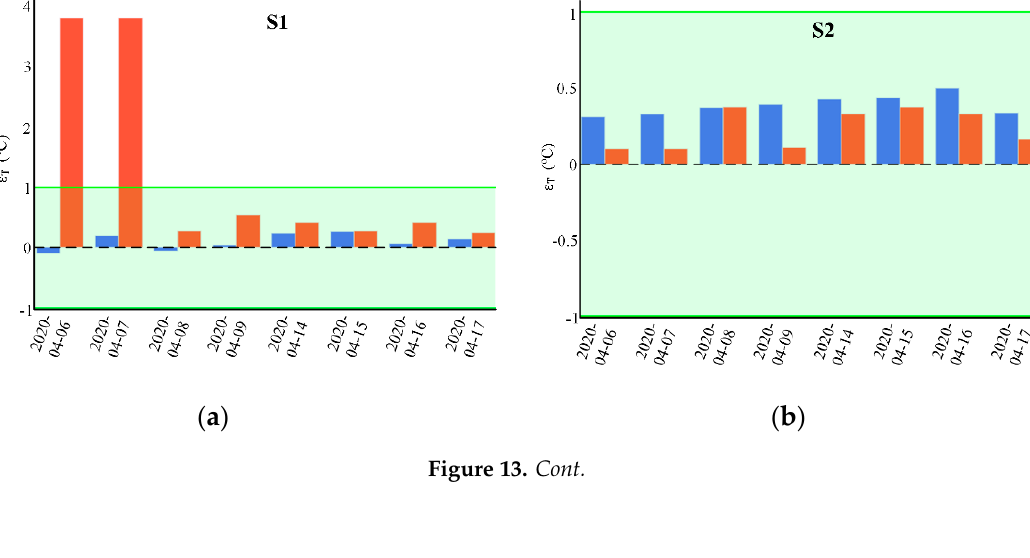
( f ) ( g ) Figure 13. Temperature error in regard to its set point of the different spaces to refrigerate. ( a – g ) Error in each space.